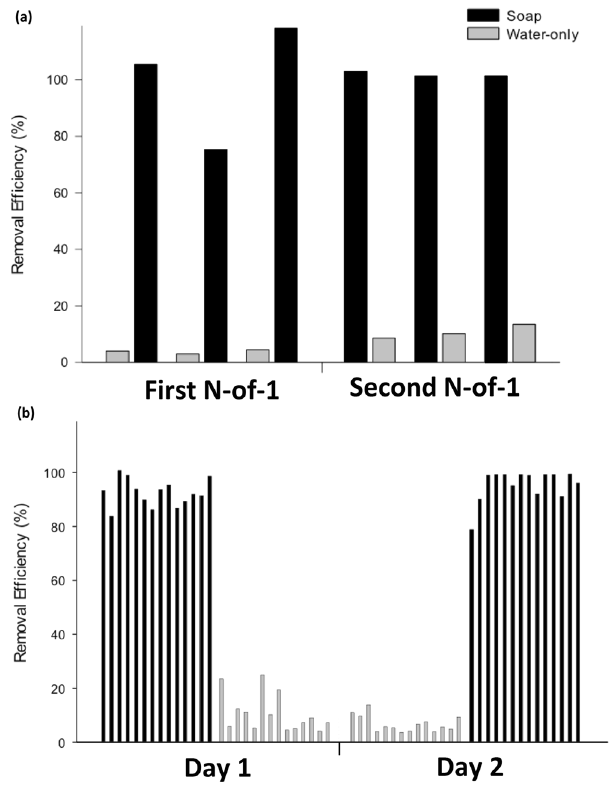
Figure 2. Removal rate of dermal DEHP exposure over both hands in each individual. ( a ) N-of-1 trials on one female subject; ( b ) The crossover study on 28 study subjects. The removal rate accomplished by handwashing with soap and water (black) or water only (gray) for each individual whose hands were exposed to 0.5 mL of 1000 μ g/mL standard DEHP